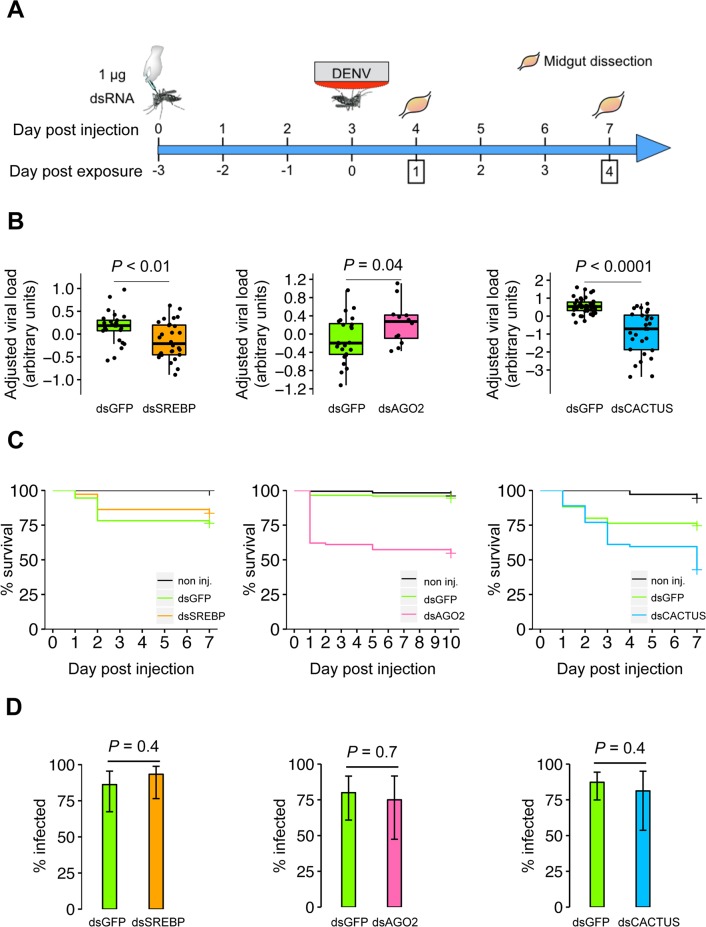
SREBP knockdown results in ∼50% reduction of midgut viral RNA load.(A) Time line of gene knockdown assays in vivo. (B) Impact of target gene knockdown on midgut viral RNA load. Boxplots represent the viral RNA load measured by RT-qPCR on day 4 post exposure in individual midguts following injection with a single dsRNA. Data represent two (for SREBP and Ago2) or three (for Cactus) separate experiments combined. Viral RNA load was adjusted for differences between experiments and expressed in arbitrary units. On day 4 post exposure, viral RNA load was reduced by 53.8% following SREBP knockdown. The P-value above the graph indicates statistical significance of the treatment assessed with an ANOVA accounting for the experiment effect. (C) Survival curves following dsRNA injection. Mosquito survival (%) is represented as a function of day post dsRNA injection for individuals injected with dsRNA targeted against SREBP (dsSREBP, left), Ago2 (dsAGO2, center) or Cactus (dsCACTUS, right). Mosquitoes injected with dsRNA against GFP (dsGFP) or non injected (non inj.) were used as controls. Each graph of the panel represents a separate experiment. Individuals were exposed to a DENV infectious blood meal 3 days post dsRNA injection. No significant difference in mortality was detected between dsGFP- and dsSREBP-injected mosquitoes according to a Cox model (P = 0.3) whereas survival of dsAGO2- and dsCACTUS-injected mosquitoes was impaired relative to the dsGFP controls (Cox model, P < 0.0001 for both genes). (D) Effect of target gene knockdown on DENV infection prevalence. Bar plots show the percentage of midguts positive for DENV infection by RT-qPCR on day 4 post virus exposure following injection with a single dsRNA. Data from two (for SREBP and Ago2) or three (for Cactus) separate experiments were combined after verifying the lack of a detectable experiment effect. Vertical bars represent 95% confidence intervals of the percentages. The P-value above the graph indicates statistical significance of the treatment effect assessed with a logistic regression.